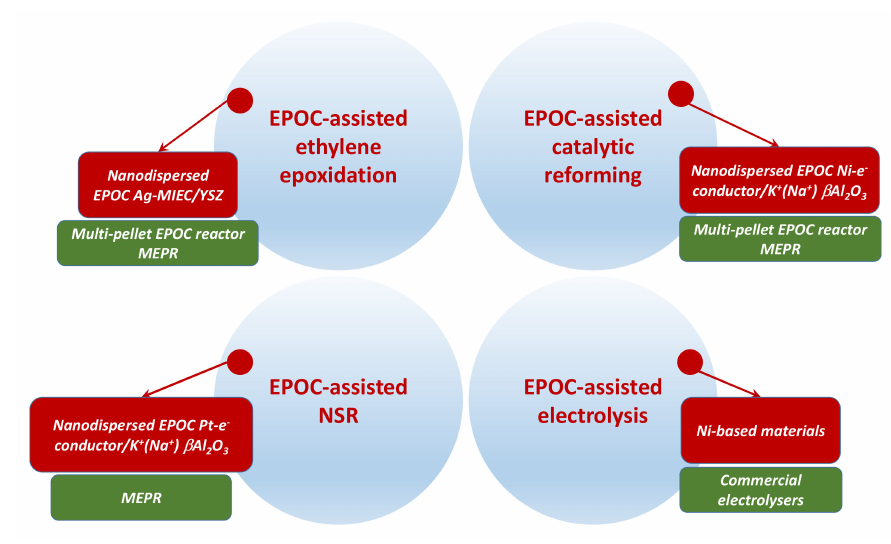
Figure 9. Most promising catalyst and reactor configurations for competitive scaled-up EPOC